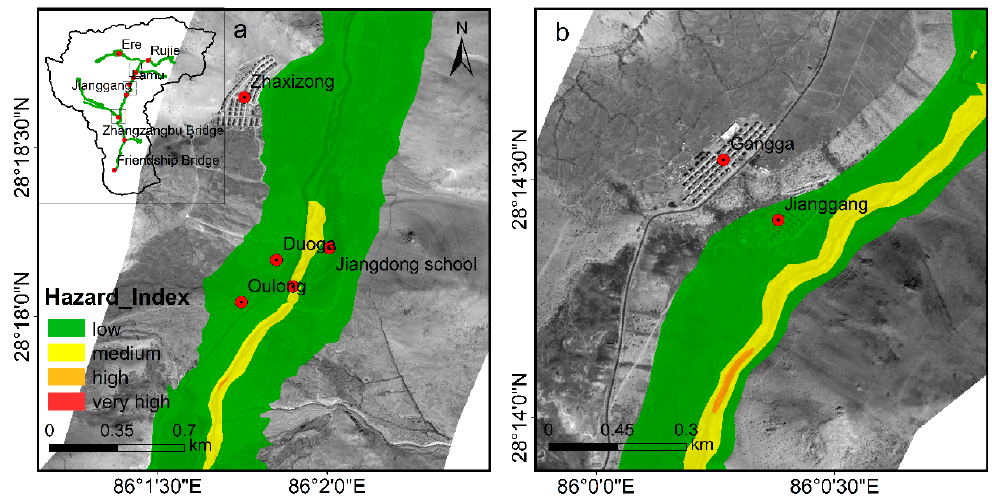
Figure 7. GLOF hazard levels along the upper Poiqu River, around the ( a ) Jiangdong Bridge, and ( b ) Jianggang village.